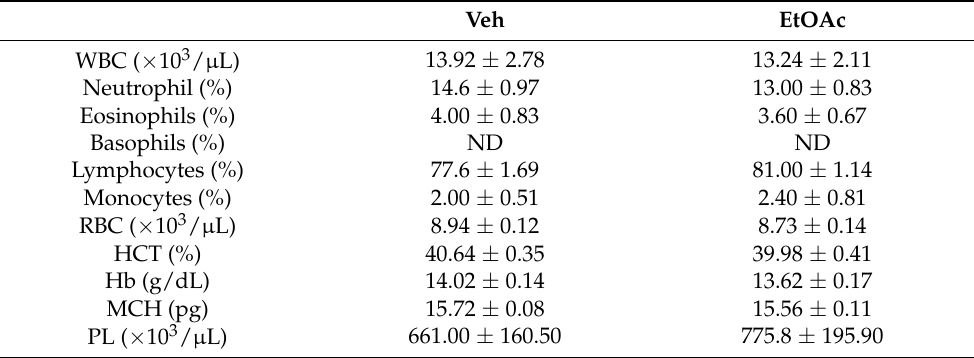
Table 3. Oral treatment with EtOAc.f did not induce changes in hematological profile of cells. Mice were treated with EtOAc.f (30 mg/Kg) or Vehicle (Veh) and comparative hematological analysis between groups was performed. WBC (White Blood Cells); RBC (Red Blood Cells); HCT (Hematocrit); Hb (Hemoglobin); MCH (Mean Corpuscular Hemoglobin); PL (Platelets); ND (not detected). Data represent mean ± S.E.M. ( n = 5